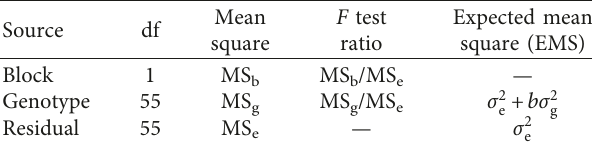
Table 2: Skeleton of the analysis of variance. Table 1: List of the 56 genotypes of durum wheat evaluated in 2014-